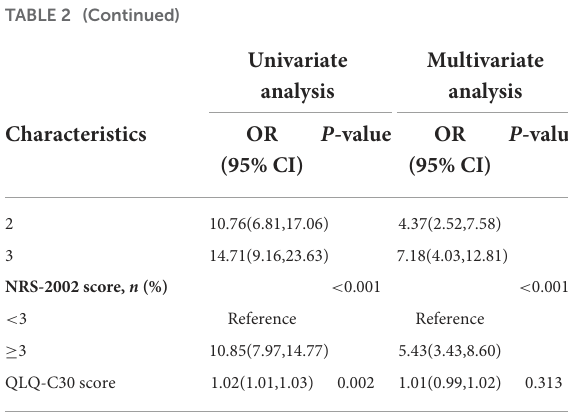
mass index; LSMD, low skeletal muscle radiodensity; NRS, nutritional risk screening; QLQ-C30,QualityofLifeQuestionnare-Core30.